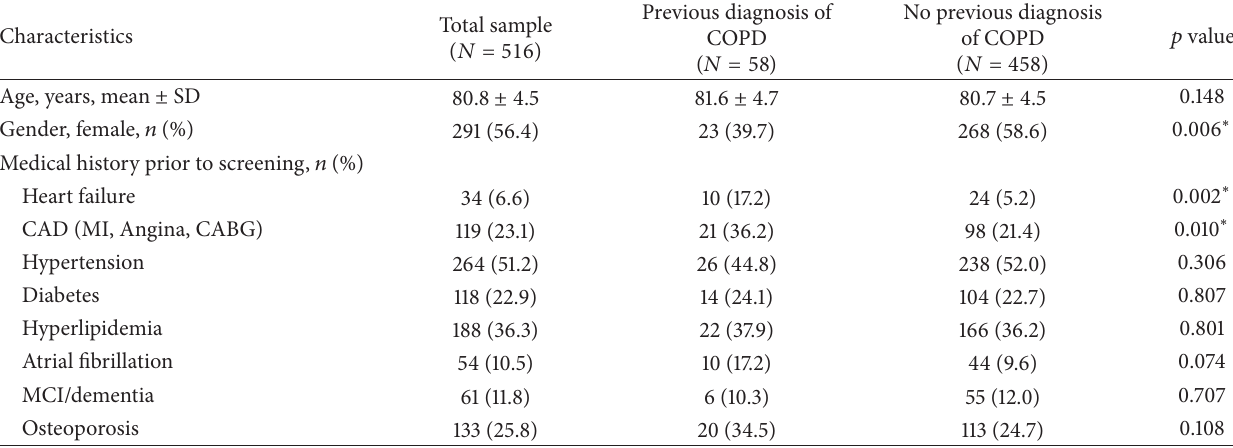
Table 1: Characteristics of all patients screened in the C5–75 program ( 𝑁 = 516